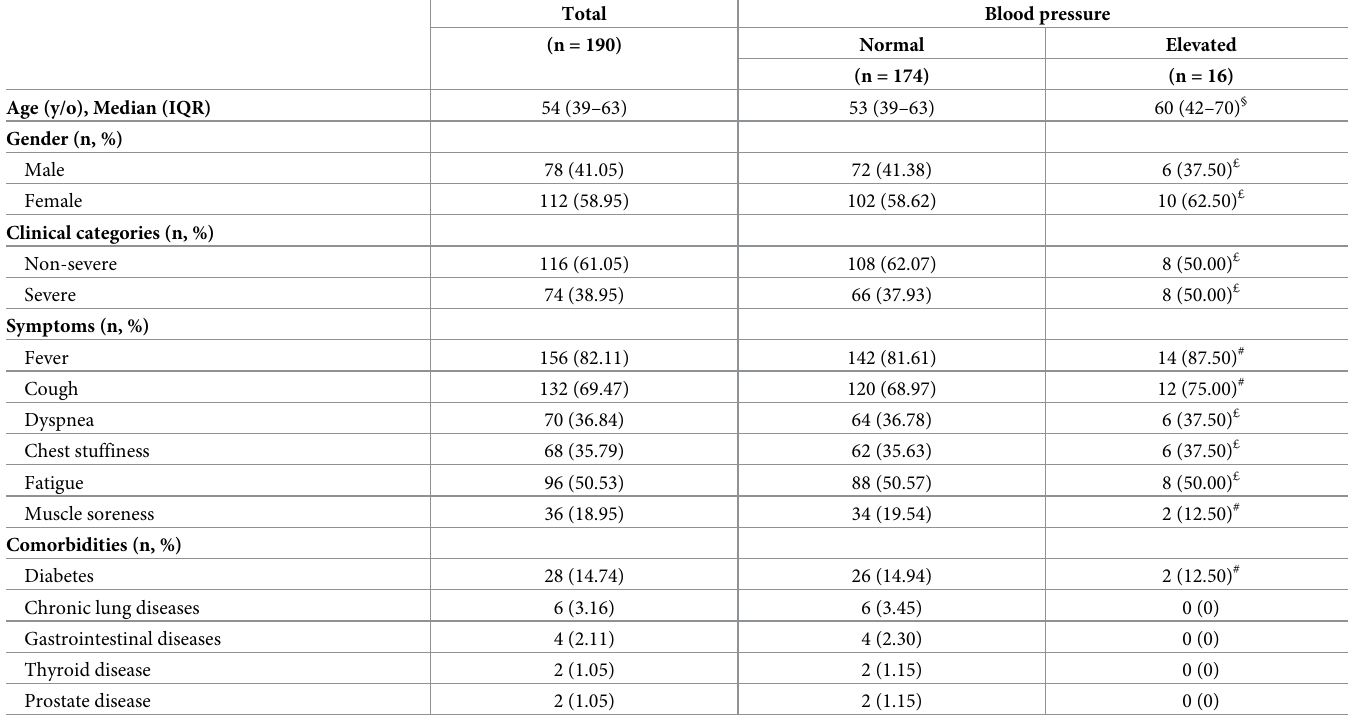
Table 3. Clinical characteristics of COVID-19 patients without prior hypertension.